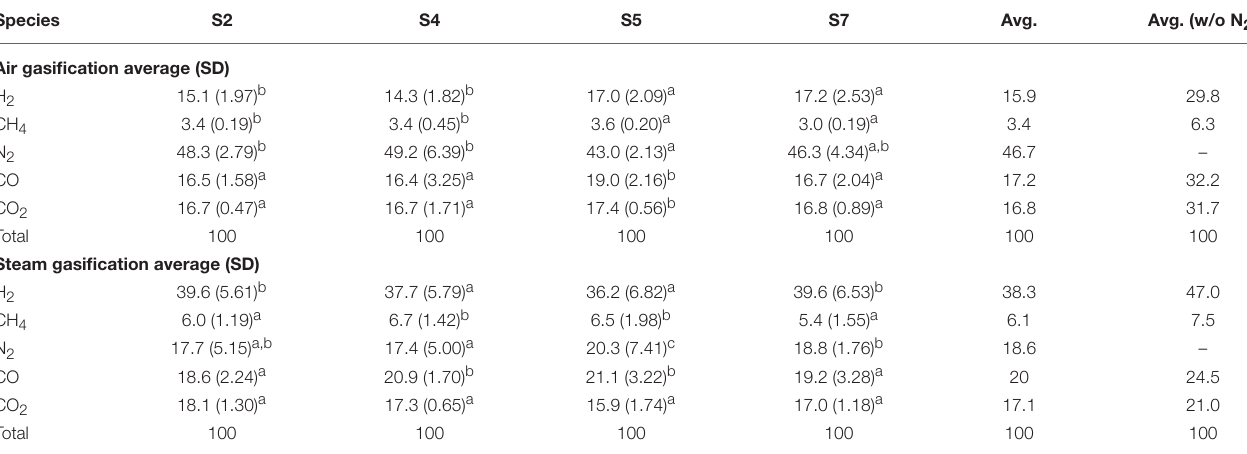
TABLE 2 | Syngas composition analyzed by online mass spectrometry (OL-MS) for air and steam gasification experiments of the four almond feedstocks. Species